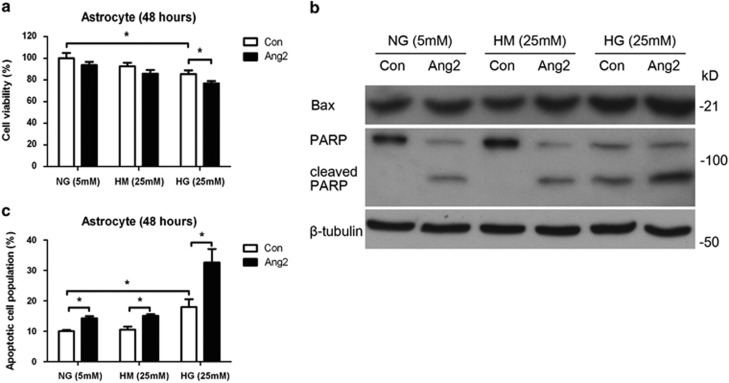
Ang2 synergistically induces astrocyte apoptosis with high glucose (HG; 25 mM glucose). The effects of Ang2 on the cell viability and apoptosis of astrocyte under HG condition were determined. Astrocytes were incubated for 48 h with Ang2 (300 ng/ml) under HG and compared with control (Con). (a) Cell viability was assessed by MTT assay. Ang2 aggravated HG-induced cell death in astrocyte. (b) Western blot analysis for Bax and cleaved PARP were performed on lysates obtained from astrocytes with the same experimental setting. β-Tubulin was used as a loading control. (c) Astrocytes were stained with annexin-V FITC and PI, and analyzed by flow cytometry. Cell apoptosis was expressed as the percentage of apoptotic cells in total cell populations. HG induced astrocyte apoptosis and Ang2 aggravated that apoptosis. The bar graphs represent mean±S.E.M. of three independent experiments. HM, high mannitol (5 mM glucose+20 mM mannitol); NG, normal glucose (5 mM glucose). *P<0.05 by Student's t-test